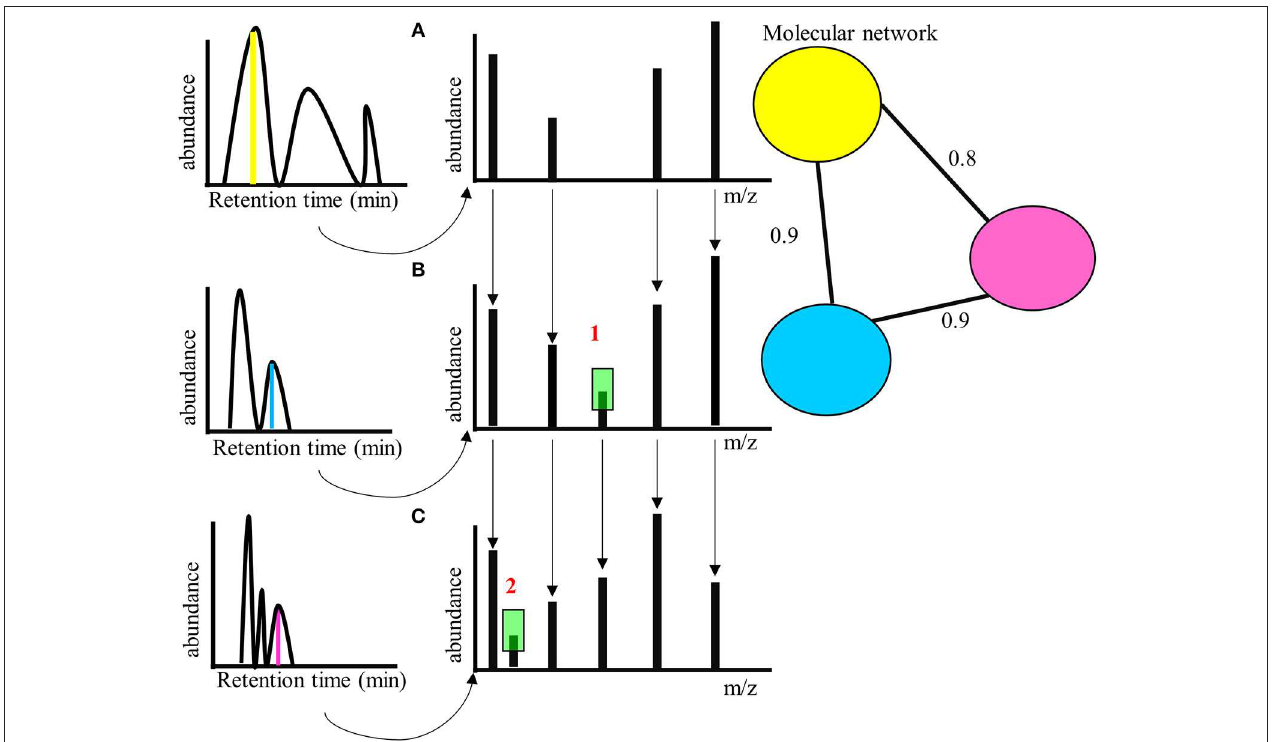
FIGURE 2 | (A) Hypothetical molecular network for three compounds eluting at different retention times, with different parent masses (left, indicated from the MS parental ion spectra in yellow, blue, and magenta)—but with similar MS/MS fragment ion spectra, right (A) , (B), and (C) . The similarity score is calculated for the MS/MS fragmentation patterns based on number of peaks that are similar across (A–C) . 1 is a single peak difference between (A) and (B) (highlighted in green)—the similarity score of yellow and blue MS/MS fragment spectra is 0.9. 2a single peak difference between (B) and (C) (highlighted in green)—the similarity score of blue and magenta MS/MS fragment spectra is also 0.9. 1 and 2 combined are two peaks difference between (A) and (C) —the similarity score of yellow and magenta MS/MS fragment spectra is therefore somewhat less = 0.8. The molecular network is generated by calculating the similarity score between yellow, blue, and magenta compounds (parent ions- the nodes in the network) based on the MS/MS fragmentation (C) , (B), and (A) . The connecting lines (edges) gives the similarity score. Threshold values of similarity can be set to determine presence within a